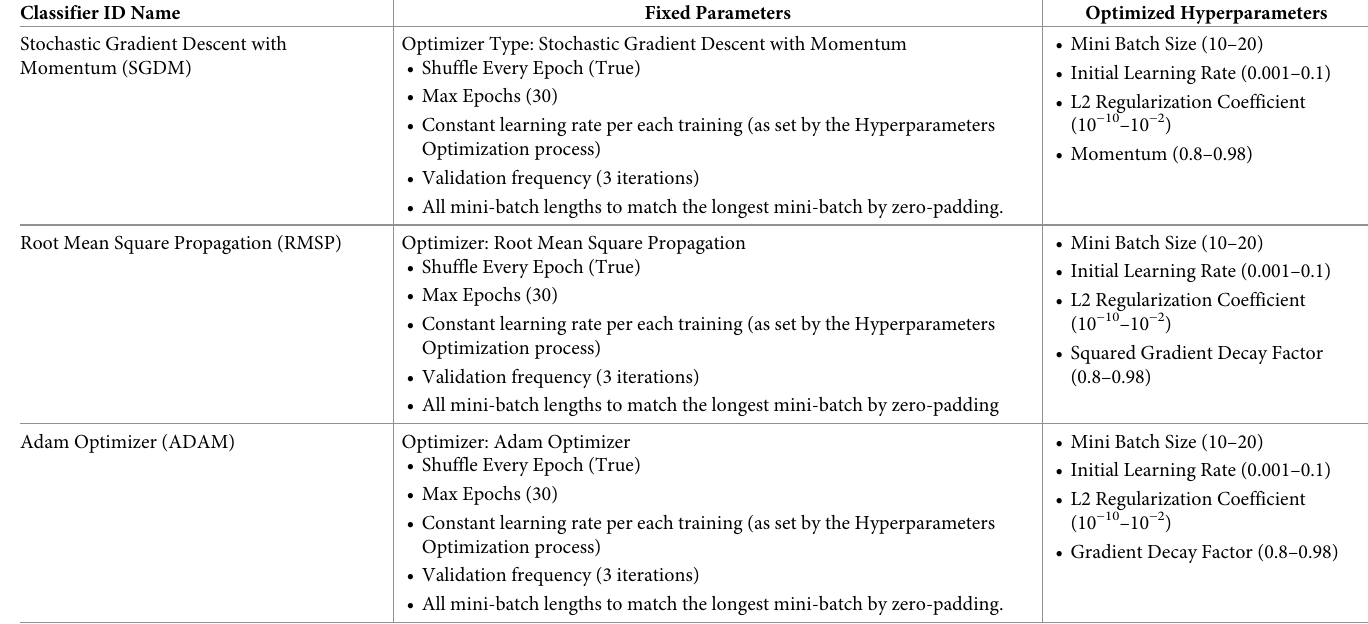
Table 5. The description of the hyperparameter optimization options and values for each FC learning optimization algorithm. Classifier ID